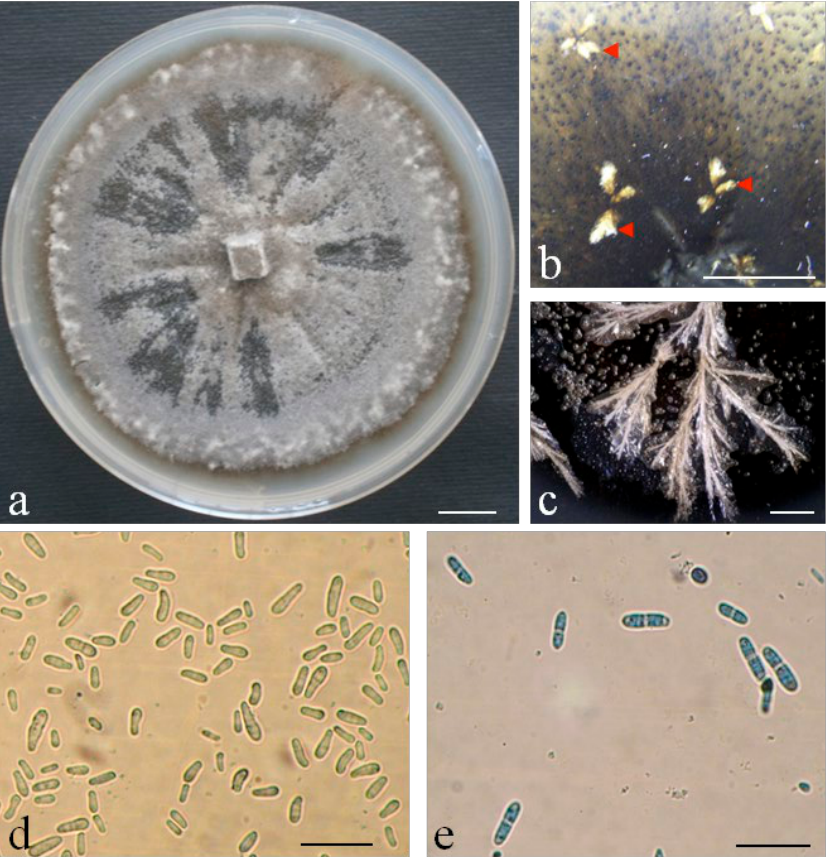
Figure 1. (a) Colony morphology of Phoma medicaginis 1 month after plating on Sanderson & Srb medium at 25°C and 16 h daily photoperiod. (b‒c) Production of crystals (red arrow) by P. medicaginis on the same medium (b) and their magnifica - tion (c). (d‒e) Non-septate (d) and one-septate (e) pycnidiospores of P. medicaginis . Bars correspond to 1 cm (a‒b), 1 mm (c) and 10 µm